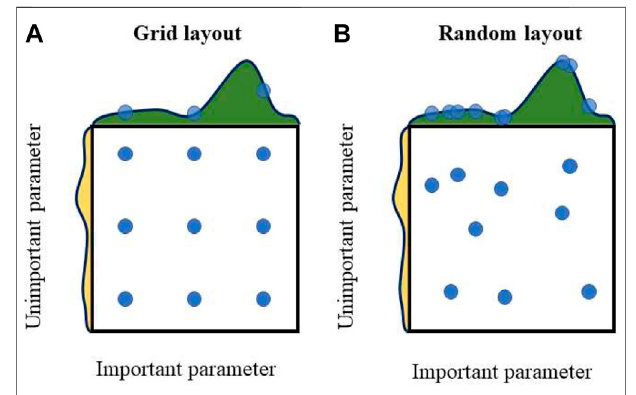
FIGURE 7 | Illustration of the (A) grid and (B) random search layouts.